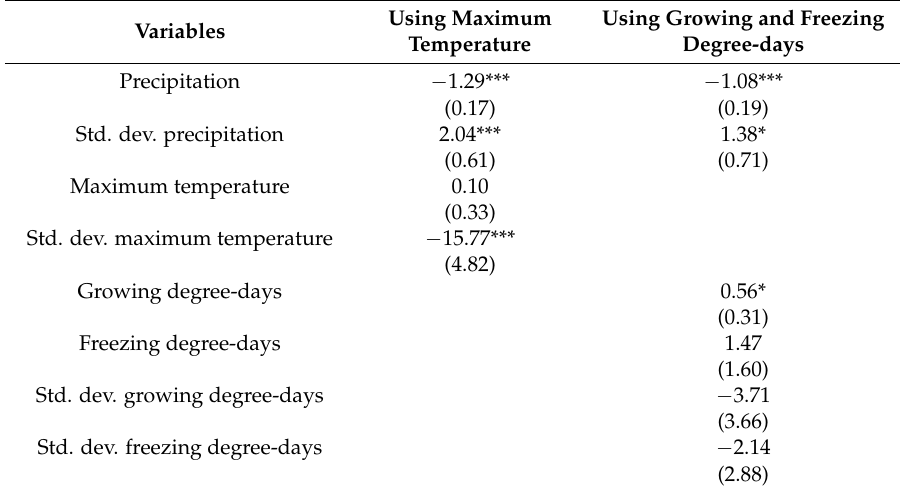
Table 3. Estimated marginal effects of climate on fallow share for robustness checks (Unit: %). Using Variables